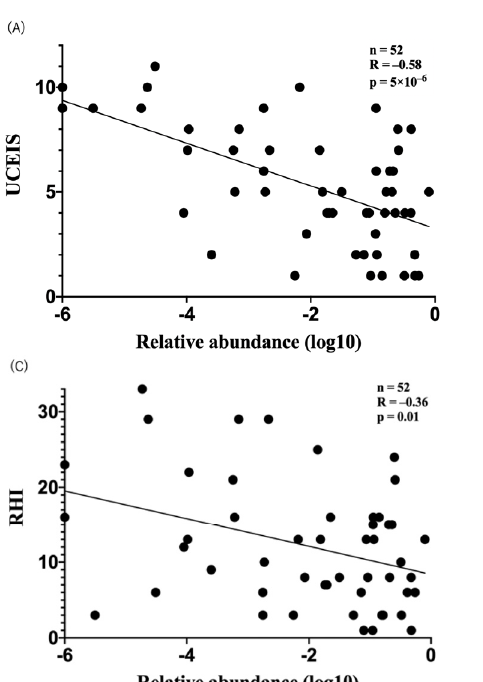
(Figure 1C), and strongly correlated with the sum of MES (R = − 0.71, p = 2 × 10 − 9 ) (Figure 1D).